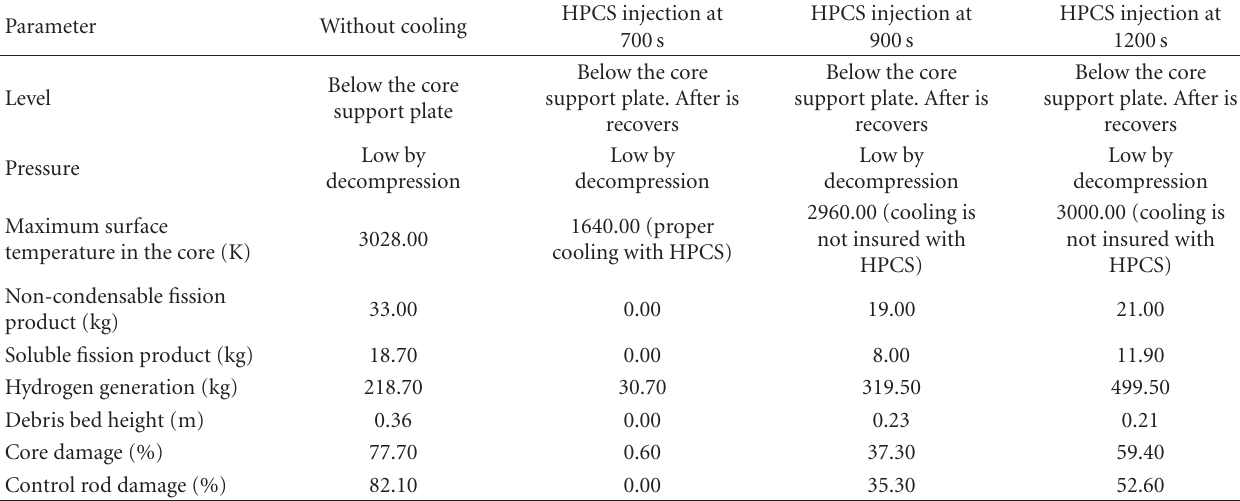
Table 2: Severe accident (LOCA) with and without